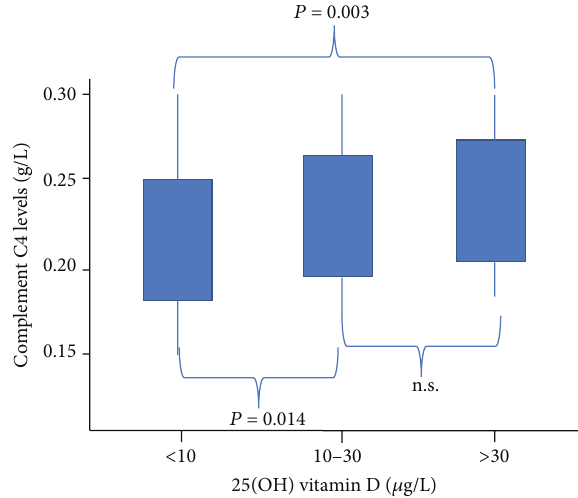
Figure 3: Complement component C4 levels depend on vitamin D sufficiency. With increasing vitamin D levels up to sufficiency (abscissa), the C4 serum levels statistically significantly increase in this cohort of healthy senior study participants > 60 years of age. From Sakem et al. 2013 [60]. A cohort of 1,470 healthy Swiss men and women, 60 years or older, were recruited for this study. A total of 179 subjects dropped out of the study because of elevated serum concentrations of C-reactive protein ( > 5mg/L) making occult inflammation suspicious. 25(OH) vitamin D was measured using HPLC and levels were corroborated by parathyroid hormone measurements (not shown). The C4 levels were measured using